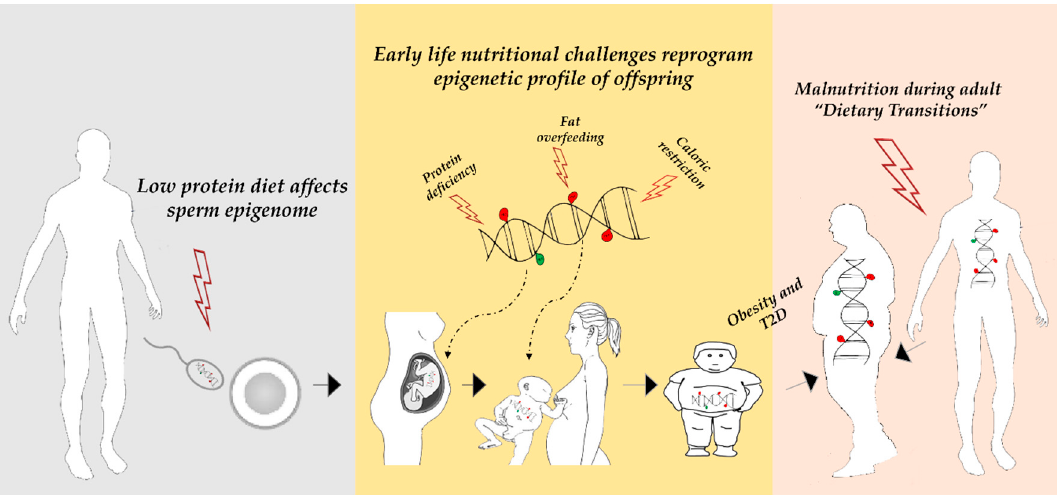
Figure 1. Altered nutritional exposures during the life time can induce persistent changes in DNA methylation, leading to an increased susceptibility to obesity and type 2 diabetes (T2D). Left: paternal low protein diet alters spermatozoa methylome. This may programme the epigenetics of the germ line which, in turn, may be inherited and influence offspring metabolic disturbance risk. Middle: early development is a period particularly vulnerable to nutritional challenges that can disrupt the correct make up of DNA methylation marks that, once established, remain highly stable. Right: exposure to a prolonged period of diet characterized by malnutrition throughout the life, may cause permanent epigenetically-associated changes in gene expression that can contribute to shape the disease phenotype.